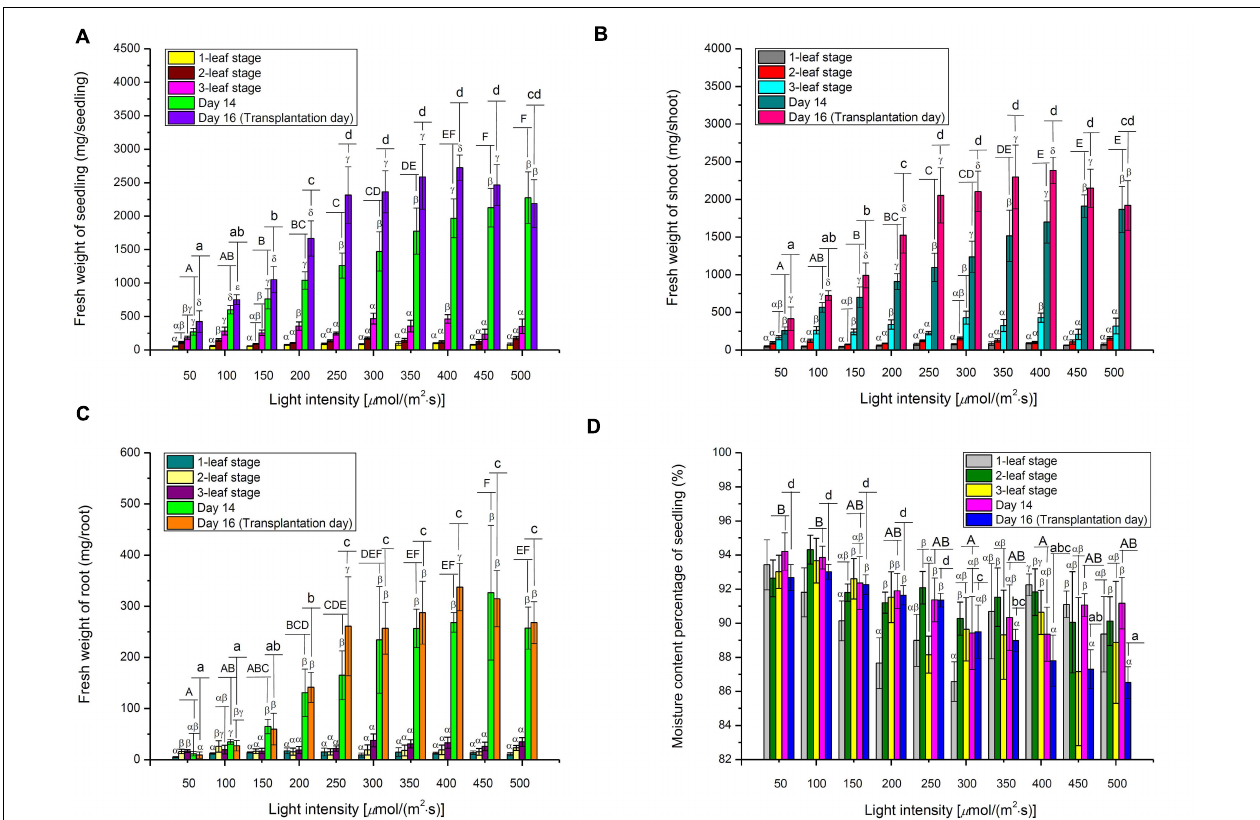
FIGURE 5 | The fresh weights of (A) Seedling, (B) Shoot, (C) Root, as well as (D) Moisture content of choy sum seedlings grown under different white LED light intensities and growth stages, as well as Day 14 and Day 16. Different Greek alphabets ( α , β , γ , and δ ) indicate significant differences among different growth stages, Day 14 and Day 16 under the same light intensity. Different upper cases (A, B, C, D, E, and F) and lower cases (a, b, c, and d) indicated significant differences among all the light intensities tested on Day 14 and Day 16, respectively ( n = 6, one-way ANOVA; Tukey multiple comparison; p <